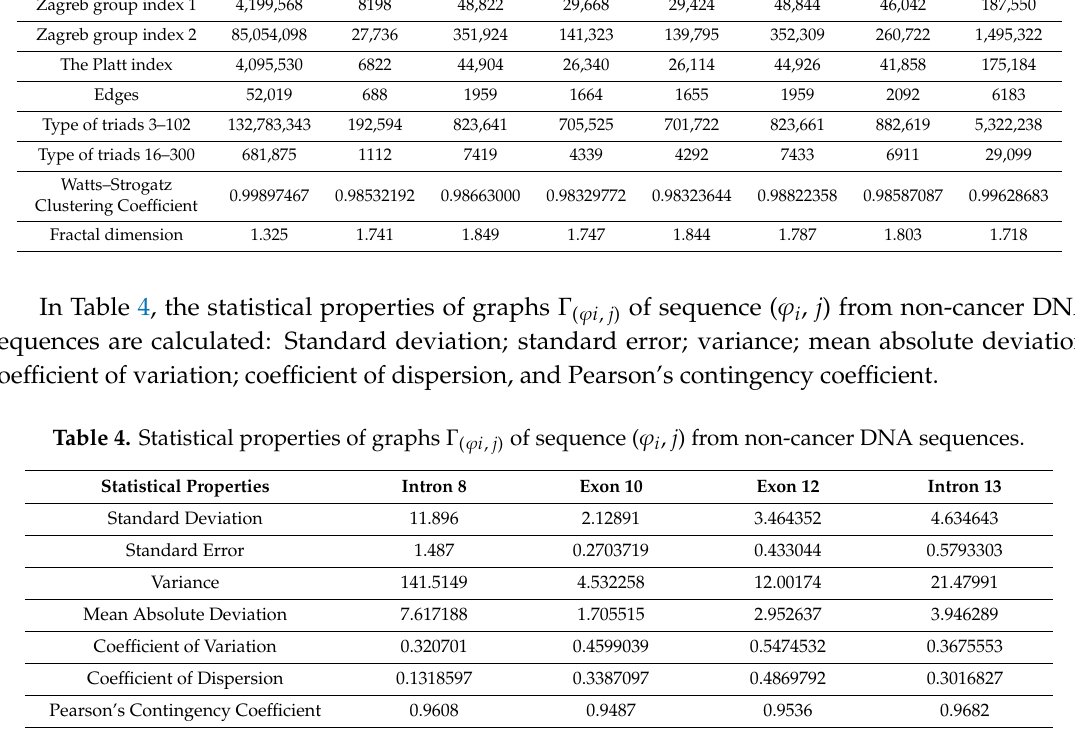
Table 3. Topological and statistical properties of the lung cancer DNA network.